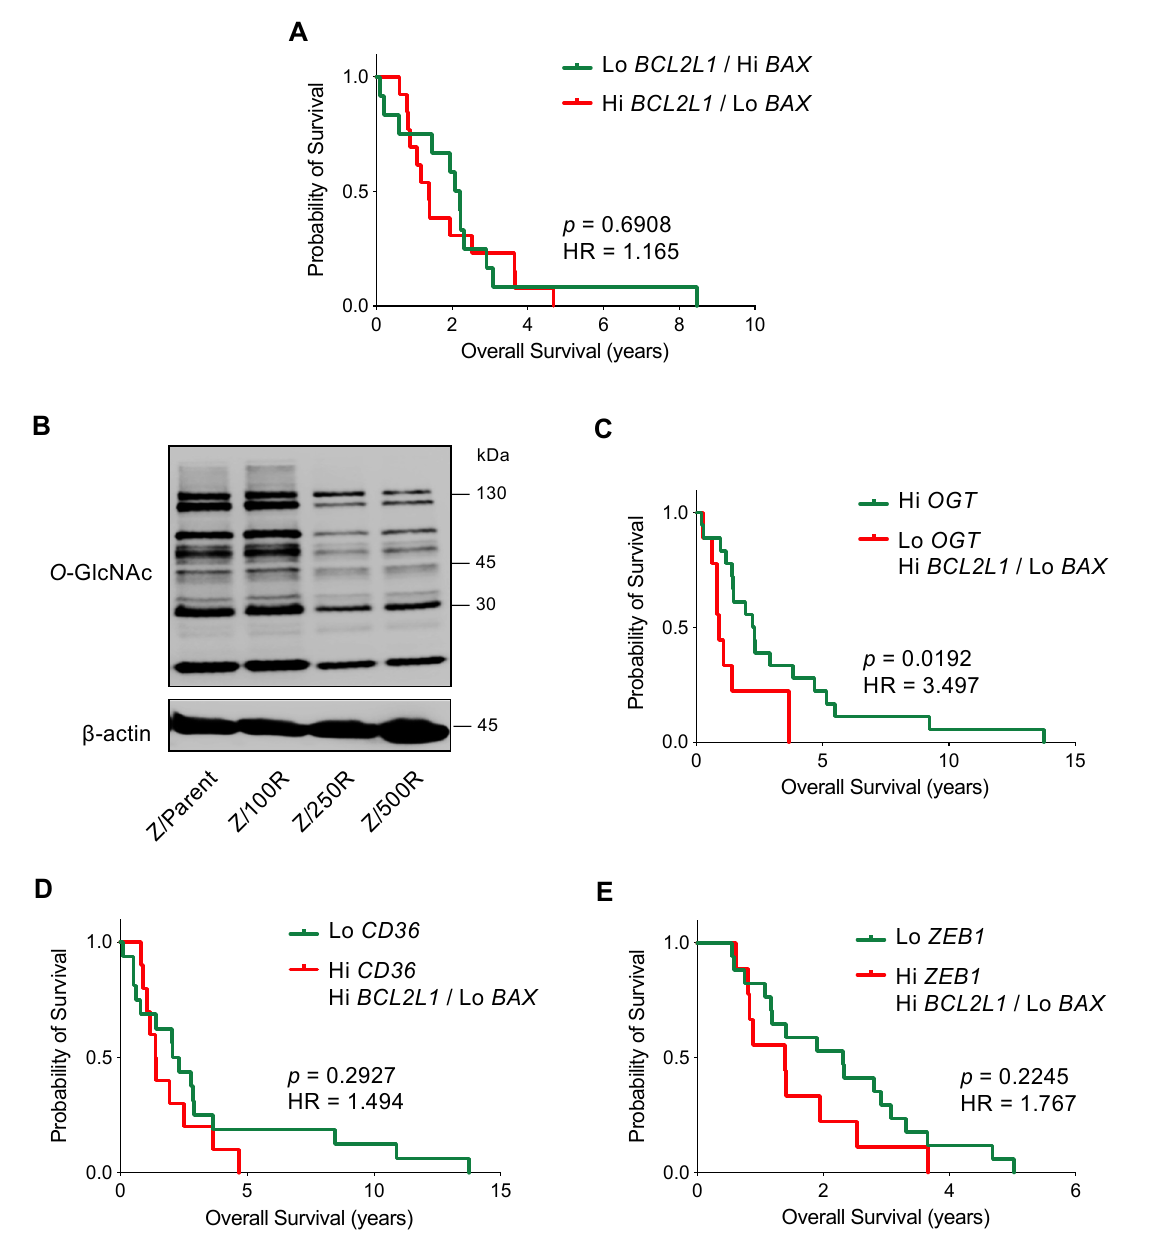
Figure 10. Kaplan-Meier survival plot of MCL patients from the gene microarrays (GSE10793) according to the levels of BCL2L1 , BAX , OGT , CD36 , and ZEB1 expression. Values above the upper quartile (Q3) were defined as high expression. ( A ) Overall survival of patients with high BCL2L1 and low BAX (red line) is compared to patients with low BCL2L1 and high BAX (green line). ( B ) Western blot analysis of global O -GlcNAc level in parental Z/Parent and BTZ-resistant Z/100R, Z/250R, and Z/500R cells showing a dose-dependent decrease in cellular O -GlcNAcylation when the cells acquired higher BTZ resistance. ( C ) Overall survival of patients with low OGT together with high BCL2L1 and low BAX (red line) is compared to patients with high OGT (green line). ( D ) Overall survival of patients with high CD36 together with high BCL2L1 and low BAX (red line) is compared to patients with low CD36 (green line). ( E ) Overall survival of patients with high ZEB1 together with high BCL2L1 and low BAX (red line) is compared to patients with low ZEB1 (green line). HR, hazard ratio.